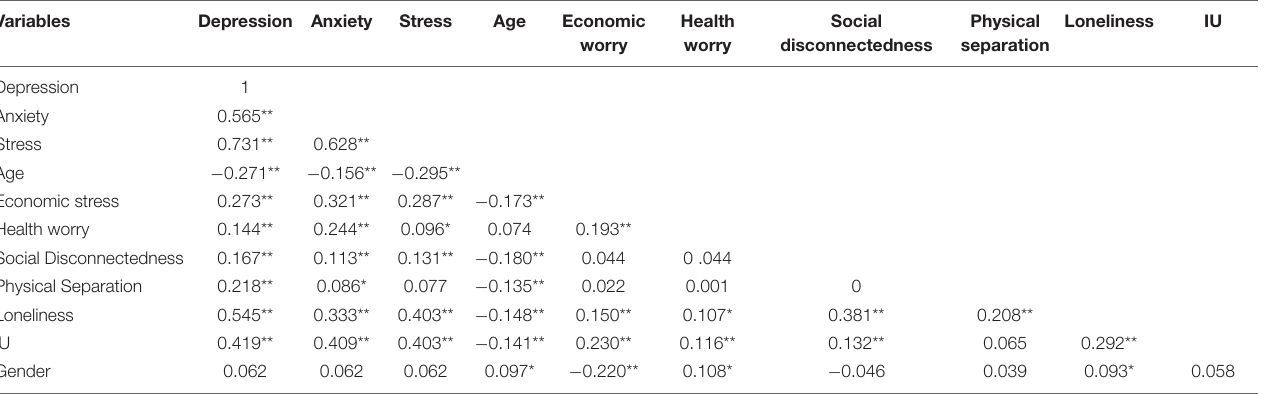
TABLE 4 | Correlation table for the variables examined in phase 1.